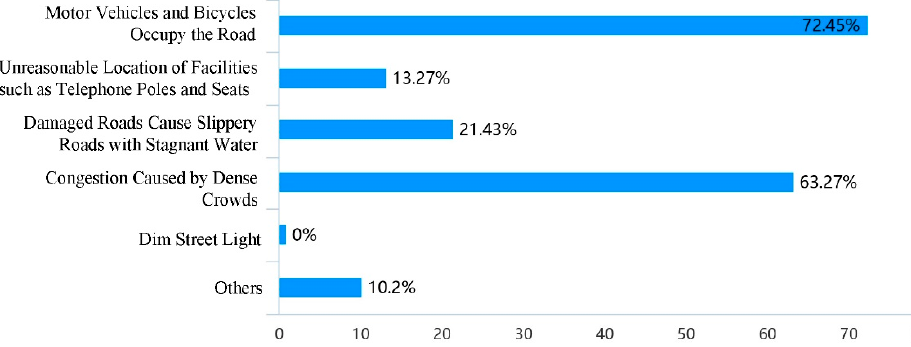
Figure 6. Factors causing unsafe walking of the current school travel road.